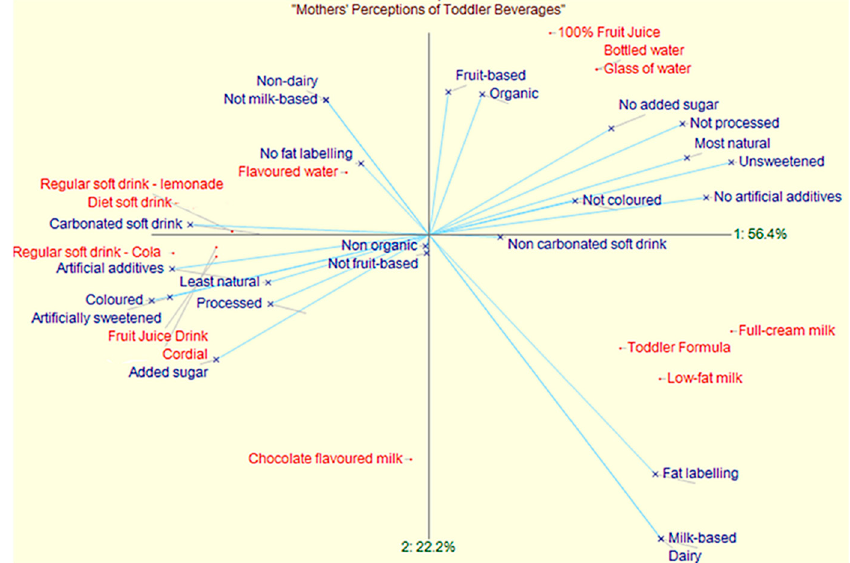
Figure 2. An example of a conceptual map of intermediate complexity.